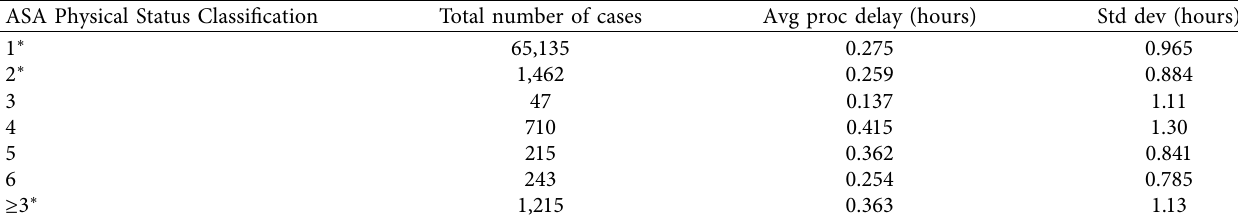
Figure 1: Statistically significant linear trend ( p < 0 . 0000001) between average procedure delay and patient BMI. Table 3: Summary statistics of procedure delays grouped by ASA Physical Status